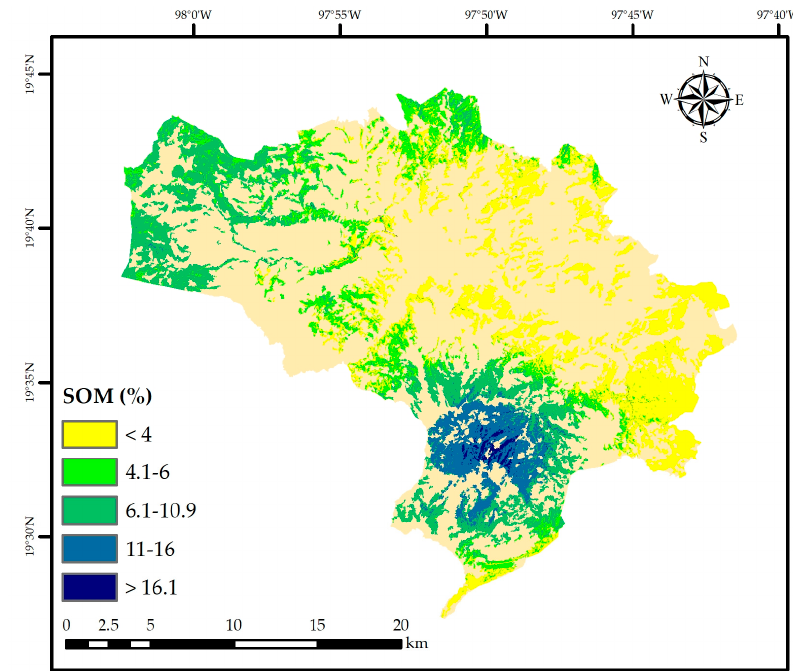
Figure 5. Map of SOM content in forest areas of Ixtacamaxtitlan, Puebla,